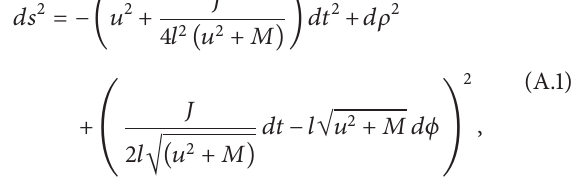
can be expanded in powers of proper distance, 𝜌 , for large values of 𝜌